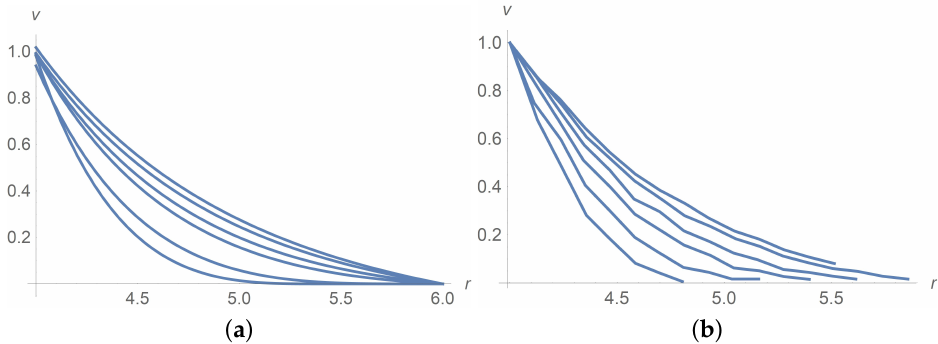
Figure 3. Dimensionless velocity profiles of the Herschel–Bulkley fluid with the apparent η HB ( φ ) and τ y ( φ ) for φ = 0.3 and Ω = 2,5,10,20,50,100 [ rpm ] from the bottom upwards. ( a ) calculations, ( b ) measured data [9].